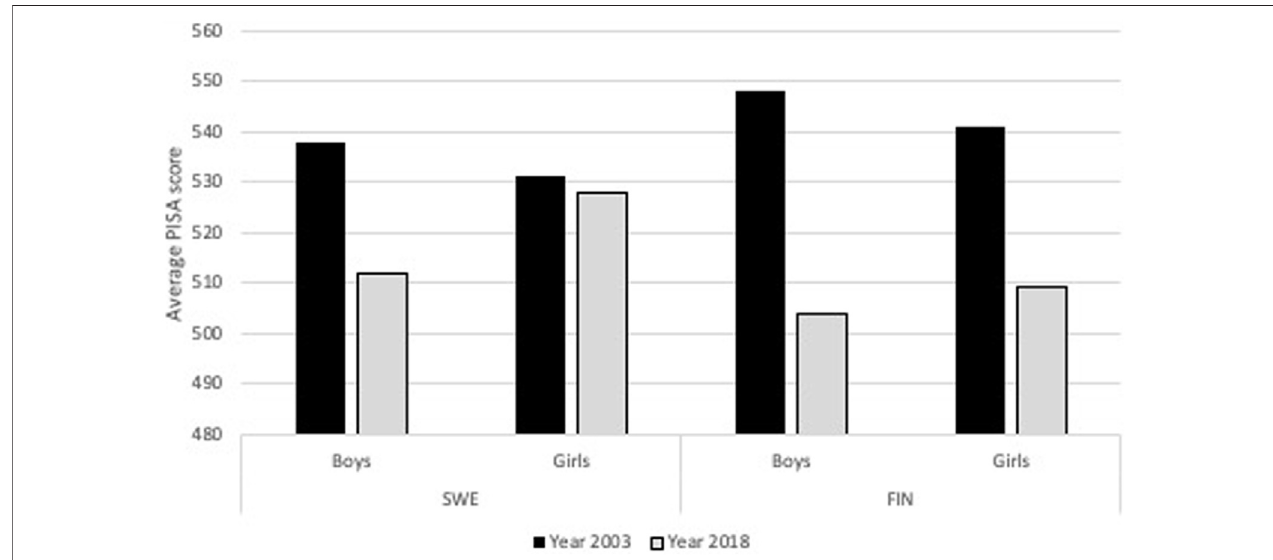
FIGURE 1 | The average mathematics attainment in PISA studies of the Finnish and Swedish-speaking samples in Finland in 2003 and 2018 (Source: OECD).